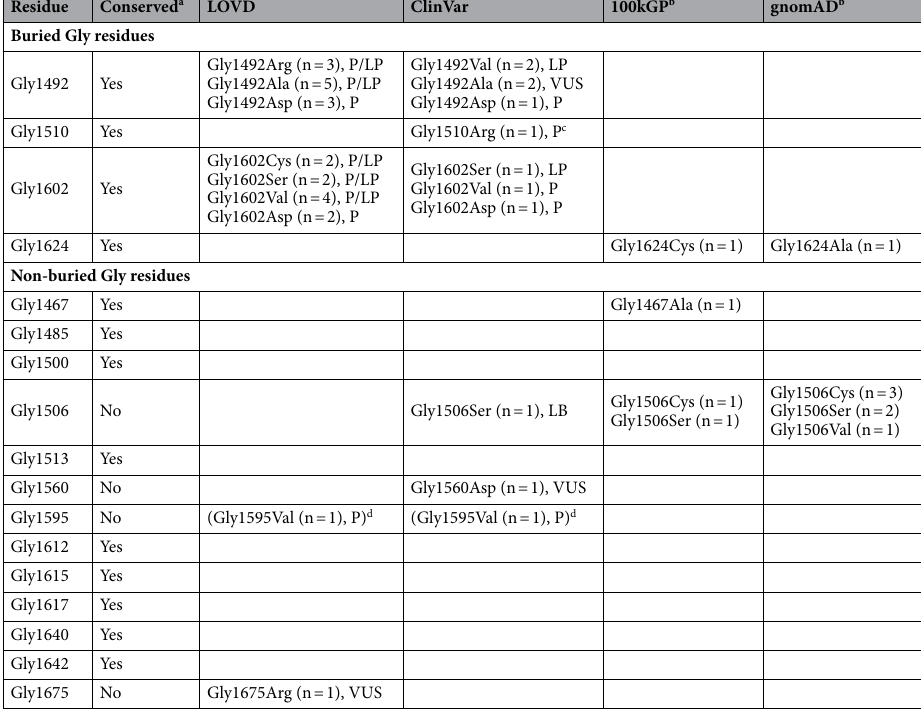
Table 4. Collagen IV α5 Gly residues and missense variants reported in LOVD, ClinVar, 100kGP and gnomAD. LB Likely Benign, LP Likely Pathogenic, P Pathogenic, VUS Variant of Uncertain Significance. a Residues fully conserved in all six human collagen IV α-chains. b Independent pathogenicity assessments were not provided by these databases. c c.4528G > C is predicted to affect normal splicing, so may not cause the expected p.Gly1510Arg missense change (Supplemental Table 2). d c.4784G > T has been demonstrated to activate a cryptic splice site rather than cause the expected p.Gly1595Val missense change 44